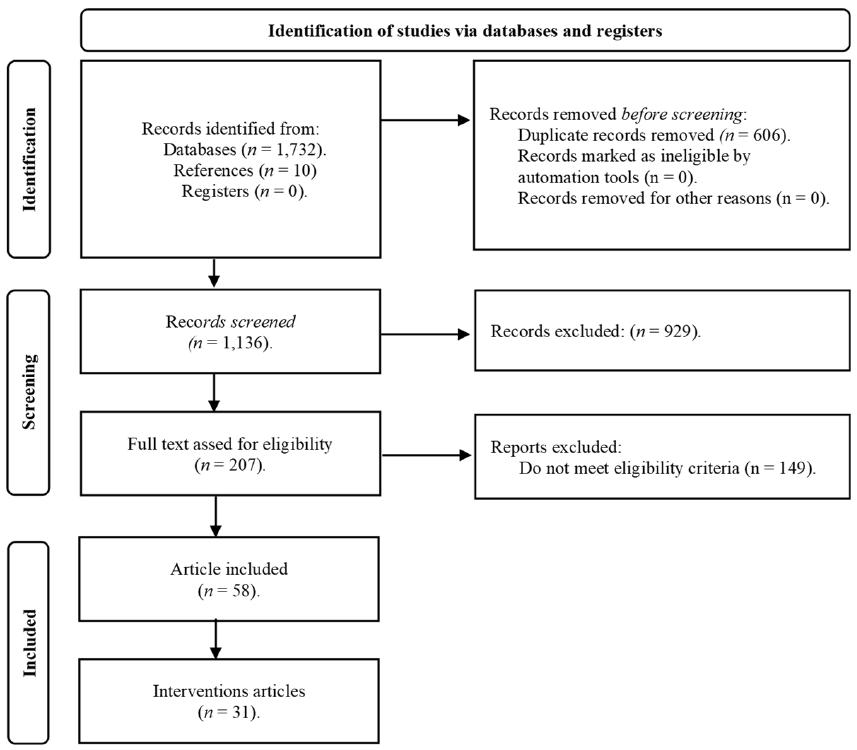
Figure 1. PRISMA Flowchart of record identification and study selection. Page et al. (2021).